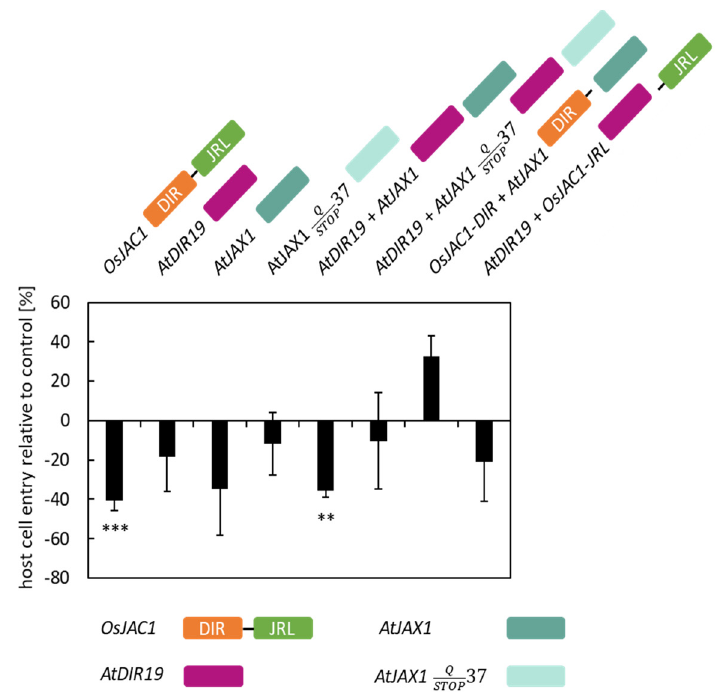
Figure 2. Testing of Arabidopsis candidate genes in a TOX assay. Primary leaves of barley were transiently transformed with constructs encoding for At DIR19 ( At1g58170 ), At JAX1 (At1g58160) , and the variant AtJAX1-STOP and combinations thereof. The effect of transient expression on the penetration success of Bgh was evaluated at 48 h p.i. Host cell entry rates were determined from the ratio of sites with successful penetration to the total number of interaction sites of spores with transformed cells. The negative control (empty vector) was set to 100%, and significant differences were determined using the Mann–Whitney rank sum test and are indicated by asterisks ( P < 0.05: *; P < 0.01: **; P < 0.001: ***). The bars represent the mean values of at least three experiments with a total of 50 to 300 interaction sites evaluated on three leaves ( n = 3) ± standard deviation. For visualization, the values of the control are taken as baseline (equal to “0%”) and, hence, the values of the test candidates can be read as differences in penetration success.